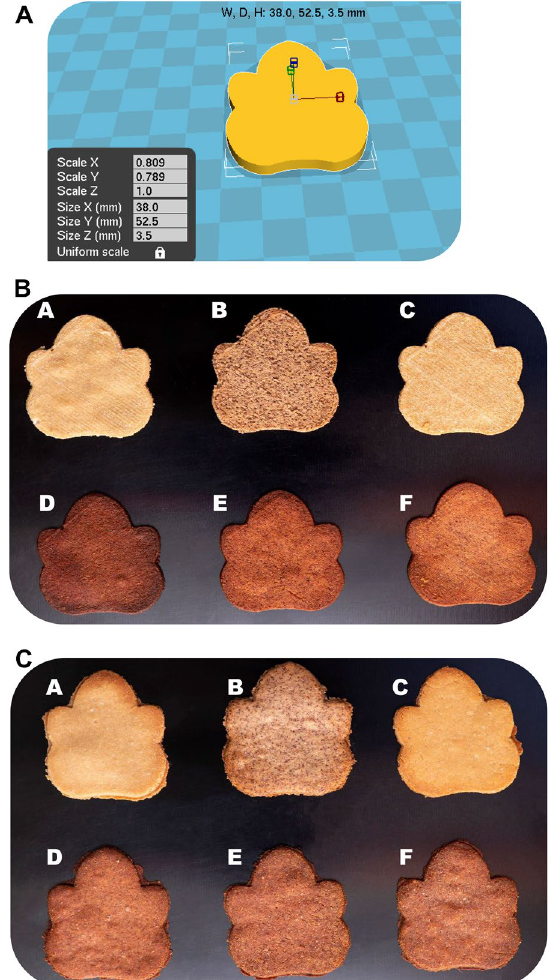
Figure 1. ( A ) The virtual three-dimensional (3D) model used for 3D-printing of prepared doughs. ( B ) Three- dimensionally (3D) printed and baked biscuits from raw, cowpea sourdough, and quinoa malt whole and multigrain flours. ( A ) Raw quinoa 3D-printed biscuit (RQ3D), ( B ) raw cowpea 3D-printed biscuit (RC3D), ( C ) quinoa malt 3D-printed biscuit (QM3D), ( D ) cowpea sourdough 3D-printed biscuit (CS3D), ( E ) 80% cowpea sourdough and 20% quinoa malt 3D-printed biscuit [CS-QM3D (80:20)], ( F ) 60% cowpea sourdough and 40% quinoa malt 3D-printed biscuit [CS-QM3D (60:40)]. ( C ) Traditional biscuits from raw, cowpea sourdough, and quinoa malt whole and multigrain flours. ( A ) Raw quinoa biscuit (RQB), ( B ) raw cowpea biscuit (RCB), ( C ) quinoa malt biscuit (QMB), ( D ) cowpea sourdough biscuit (CSB), ( E ) 80% cowpea sourdough and 20% quinoa malt biscuit [CS-QMB (80:20)] ( F ) 60% cowpea sourdough and 40% quinoa malt biscuit [CS-QMB